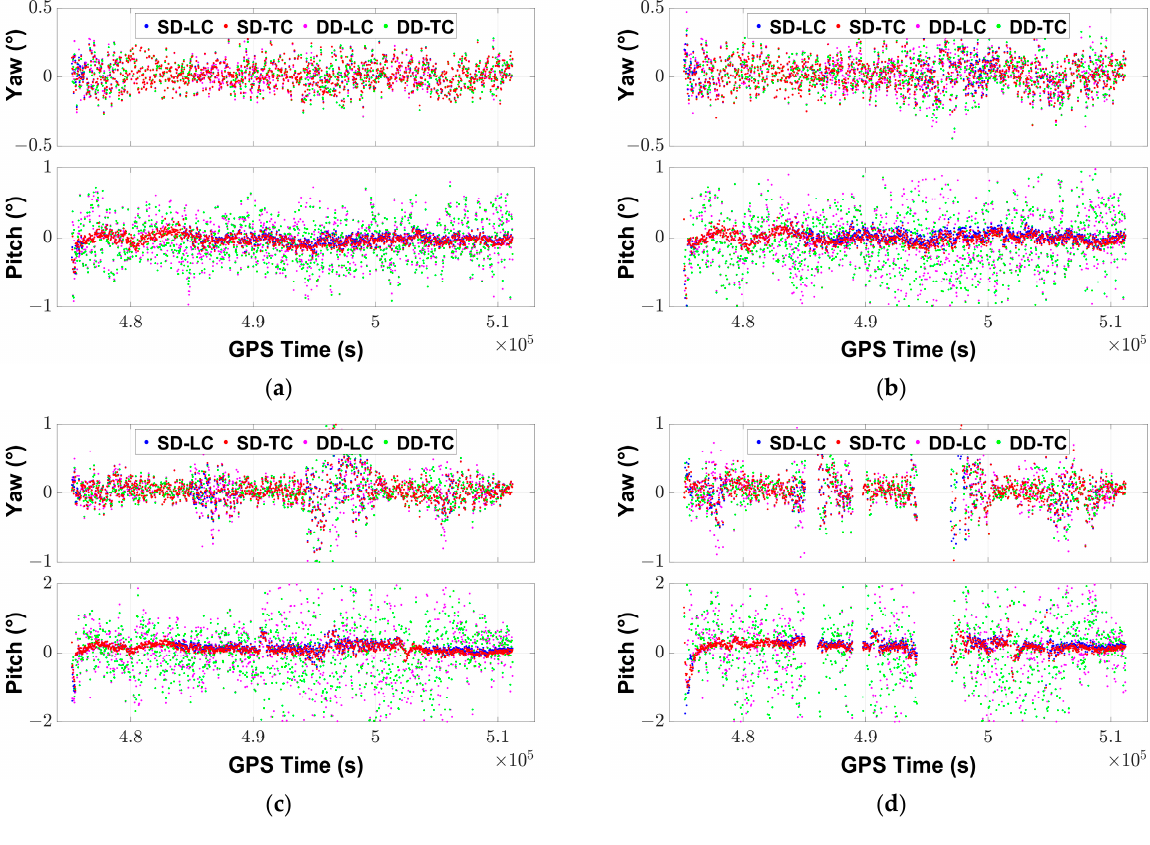
Figure 8. The yaw and pitch error series of the DD-LC, DD-TC, SD-LC, and SD-TC models under different elevation cutoff angles in the multi-epoch solution: ( a ) 20 ◦ ; ( b ) 30 ◦ ; ( c ) 40 ◦ ; and ( d ) 45 ◦ Table 10. The yaw and pitch RMS errors of the DD-LC, DD-TC, SD-LC, and SD-TC models under different elevation cutoff angles in the multi-epoch solution.